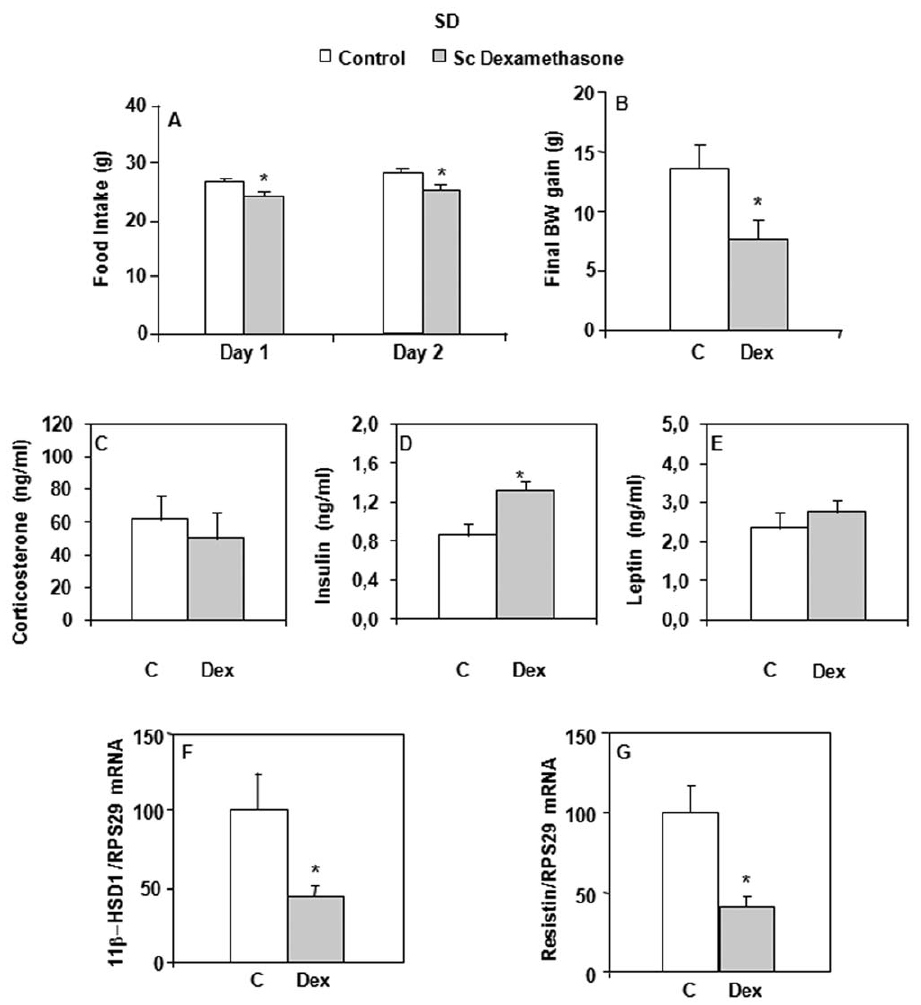
Figure 7. Food intake, body weight gain, corticosterone, insulin, leptin levels, 11 b -HSD1 and resistin mRNA expression in SD rats. Effects of peripheral (sc) dexamethasone infusion for 3 days. A) Results are expressed as food ingested (in grams) each day of peripheral infusion. B) Results represent body weight gain (in grams) measured after 2 days of treatment. C to E) Plasma levels of corticosterone, insulin and leptin. F and G) Results are expressed as percent of relative mRNA expression compared to that obtained in control rats (100%). The analysis was performed in duplicate and the results were normalized with RPS29 expression. Mean 6 SEM of n =8–9 rats per group. * P , 0.05 compared to vehicle-infused control rats (Student’s t test).